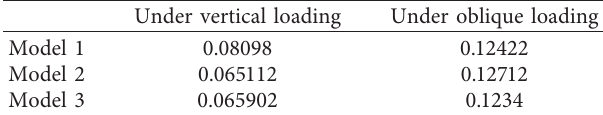
Table 3: Maximum values of natural tooth vertical displacement in the apical area